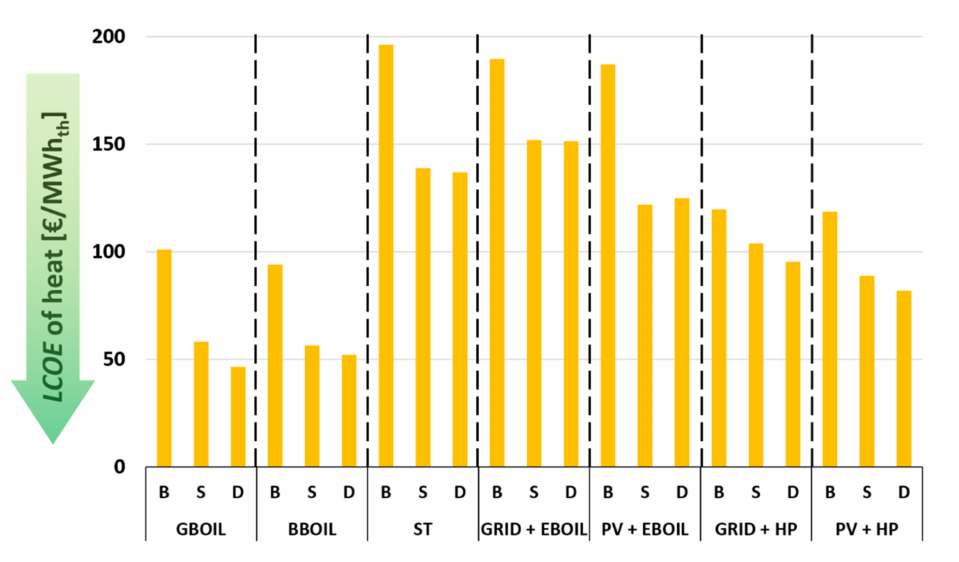
Figure 4. Overall LCOE of heat for every solution at every scale. D = district-scale sizing; S = sector-scale sizing; B = building-scale